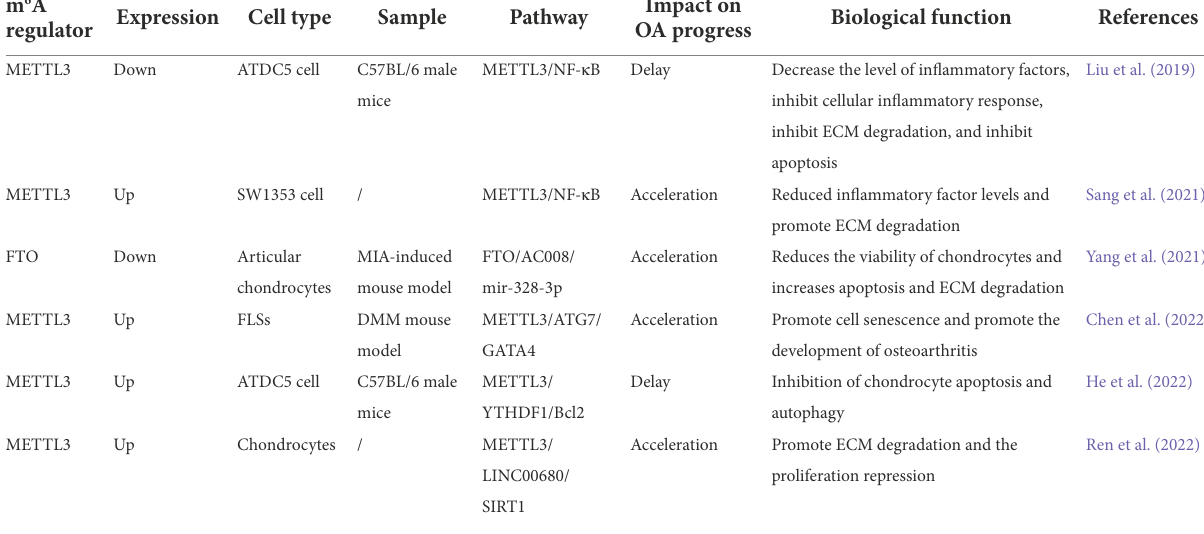
TABLE 1 Roles of m 6 A key regulator in